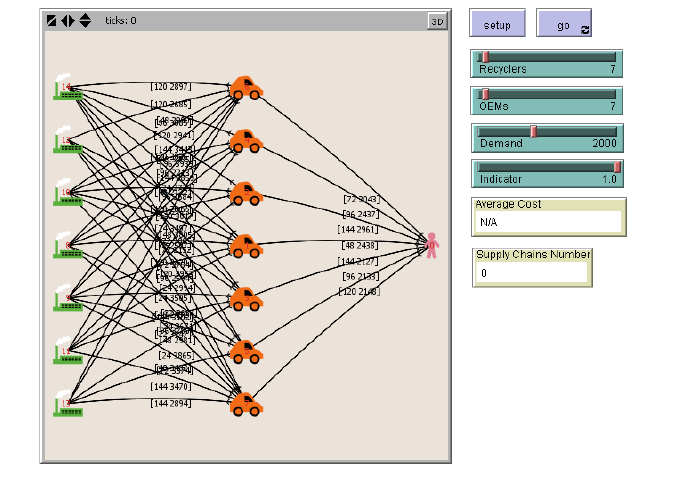
Figure 2. Reverse network of automotive industry in the NetLogo